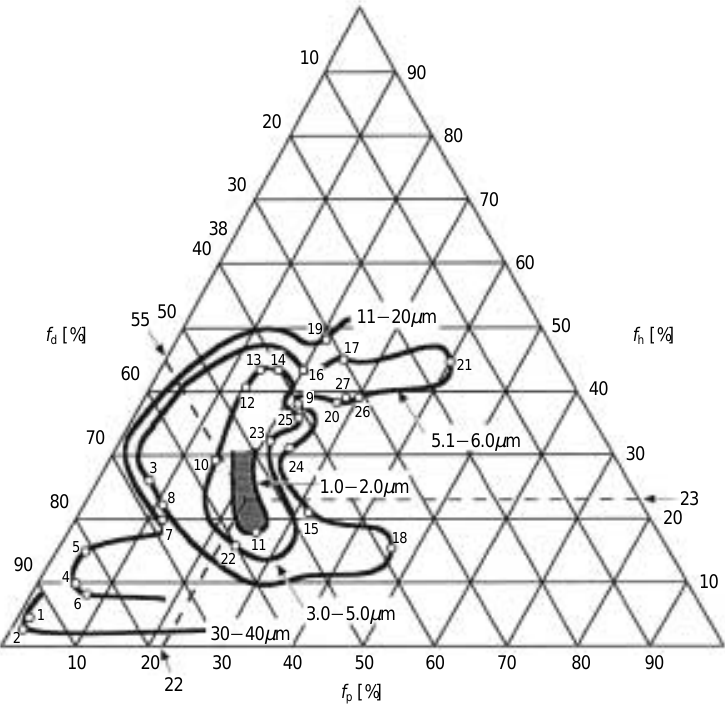
Fig. 5 Isometric particle lines on triangular chart for Fe 2 O 3 (Each number means a solvent listed in Table 1